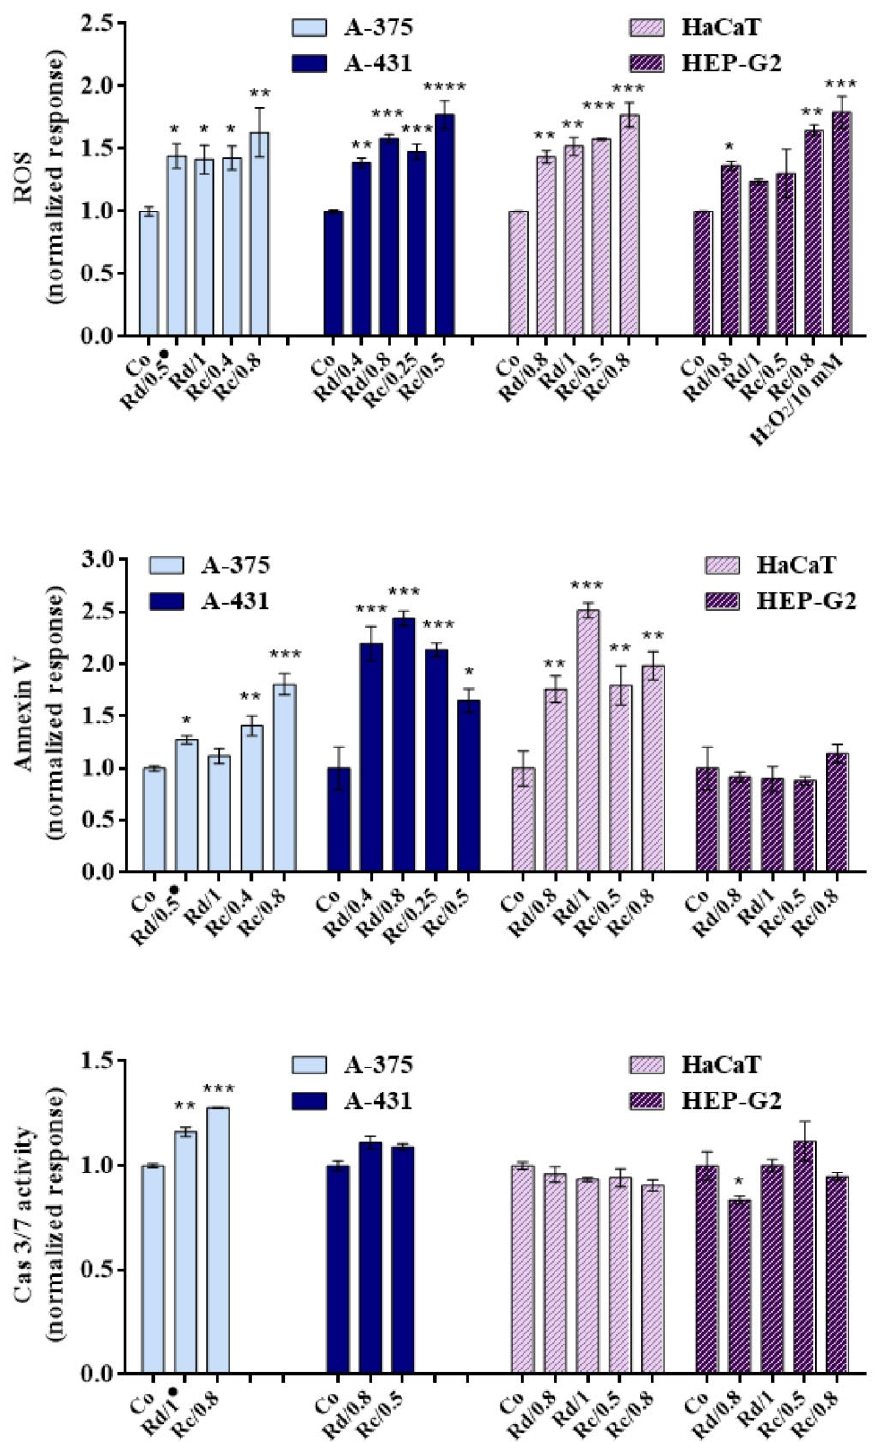
Figure 3. Generation of reactive oxygen species and induction of apoptosis after treatment of tumorigenic and non-tumorigenic cell lines with wastewater from two Rosa spp. for 48 h. Legend: Co: control; Rd: R. damascena Mill.; Rc: R. centifolia L.; • : volumetric concentration (%). Significant deviations from the untreated controls are denoted with asterisks (* for p < 0.05, ** for p < 0.01, *** for p < 0.001, **** for p < 0.0001).